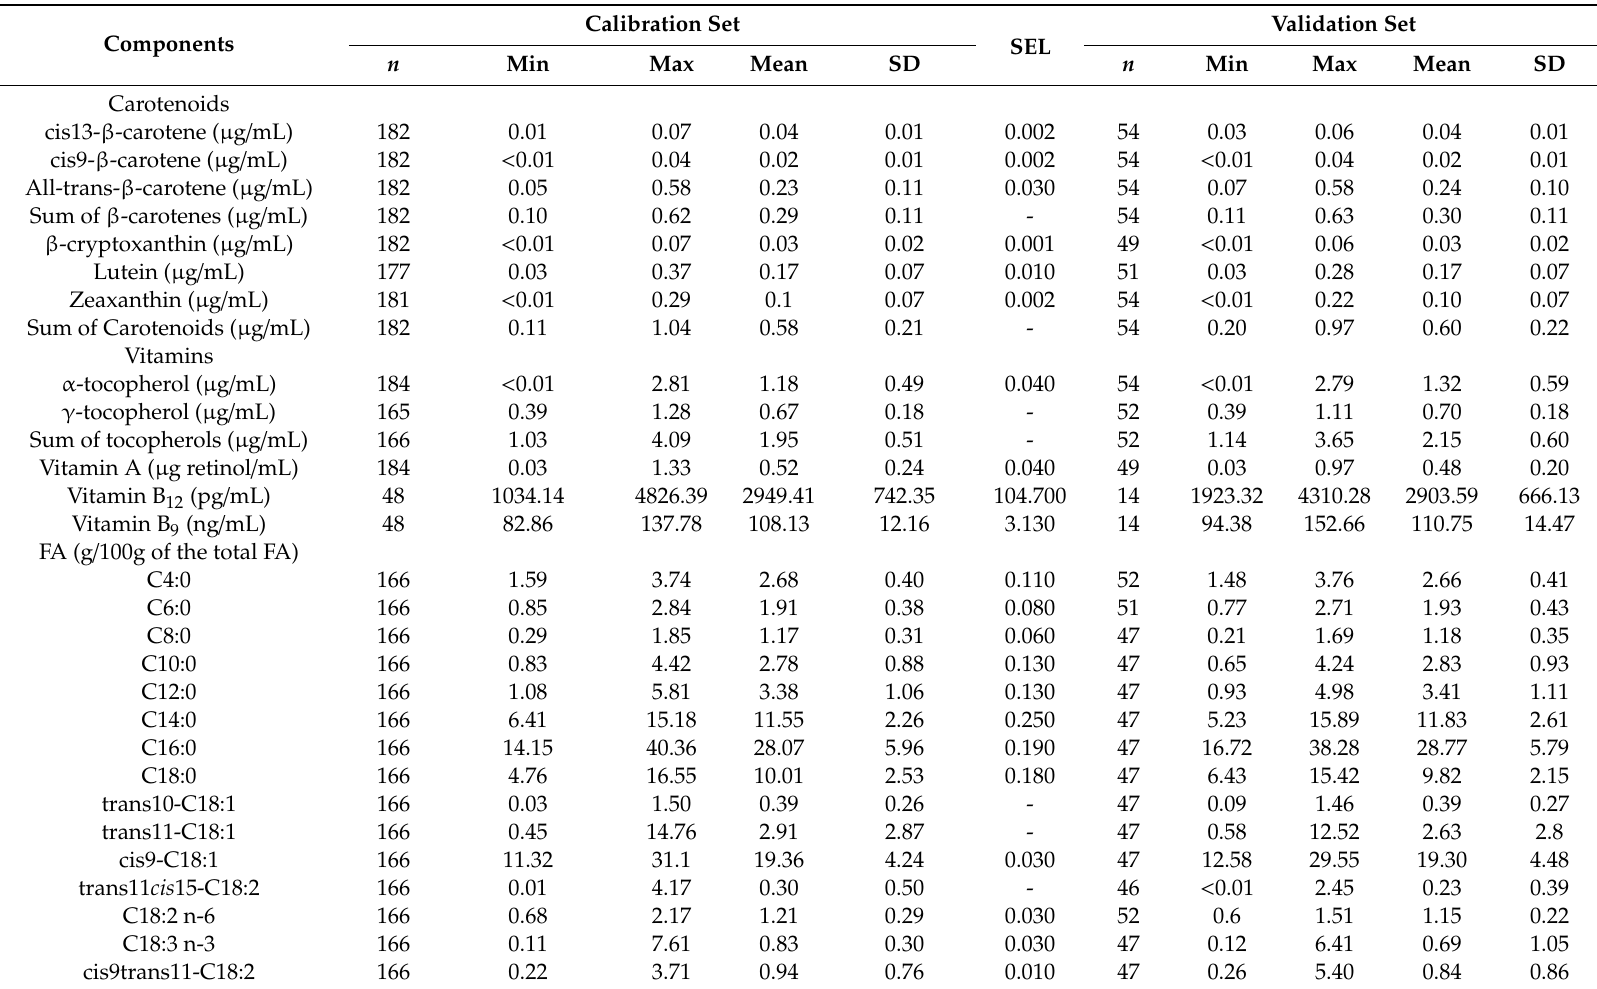
Table 2. Descriptive statistics of carotenoids, vitamins and selected fatty acids (FA, expressed in g / 100 g of the total FA) in the calibration and validation sets used for near-, mid-infrared and fluorescence spectroscopy